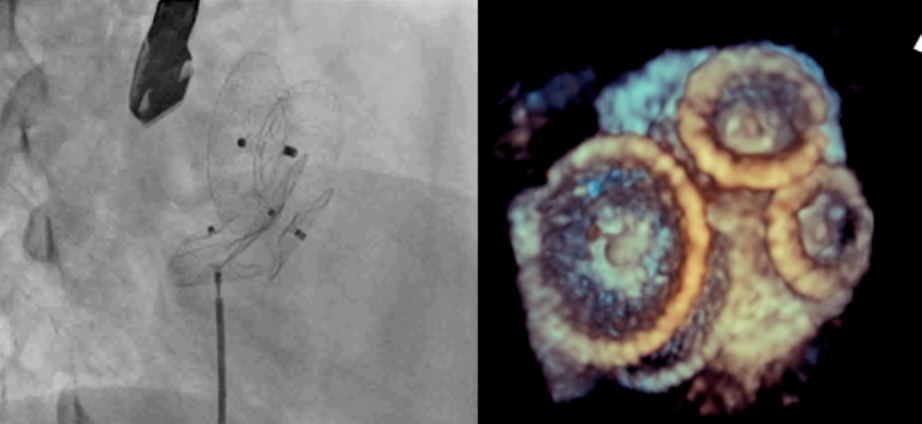
Figure 1. Implantation of 28, 16 and 12 mm Amplatzer septal occluders guided by real-time three- dimensional transesophageal echocardiography.